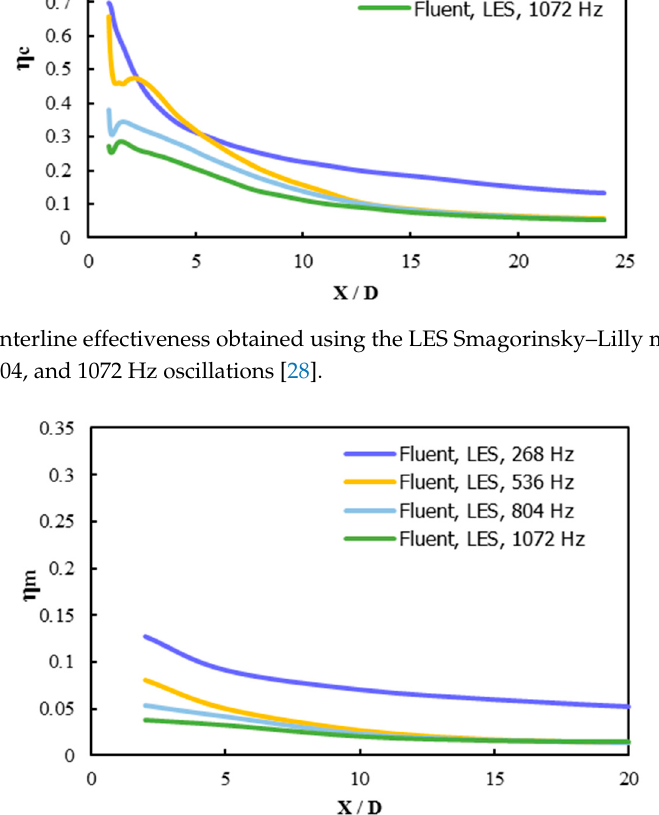
Figure 27. The centerline Stanton number ratio obtained using the DES Realizable k - ε model for M = 0.5 for the 268, 536, and 804 Hz oscillations. Figure 28. The spanwise-averaged Stanton number ratio obtained using the DES Realizable k - ε model for M = 0.5 for the 268, 536, and 804 Hz oscillations.